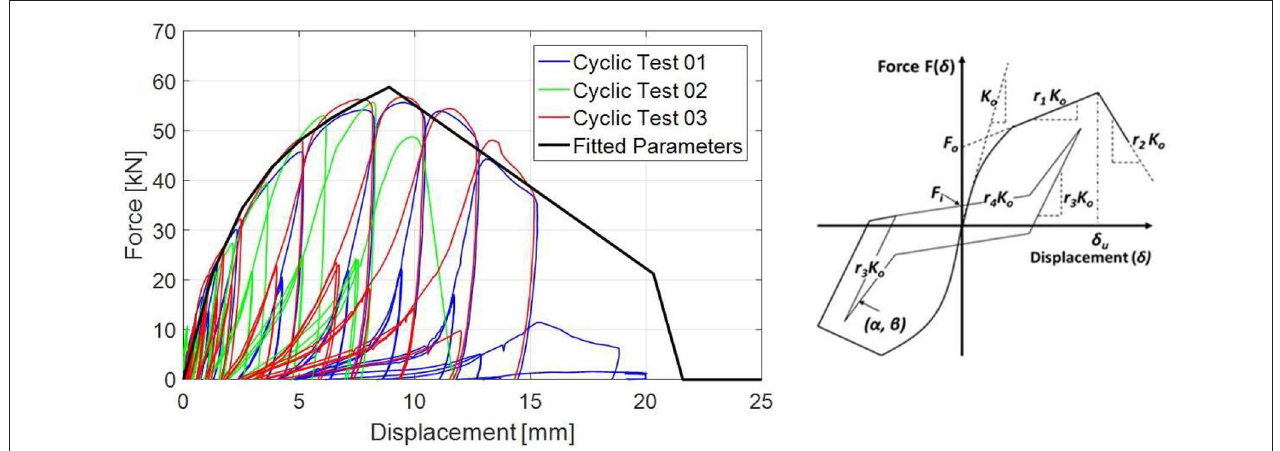
FIGURE 4 | Experimental uplift test data (Left) and MSTEW hysteretic model rules (Right) .